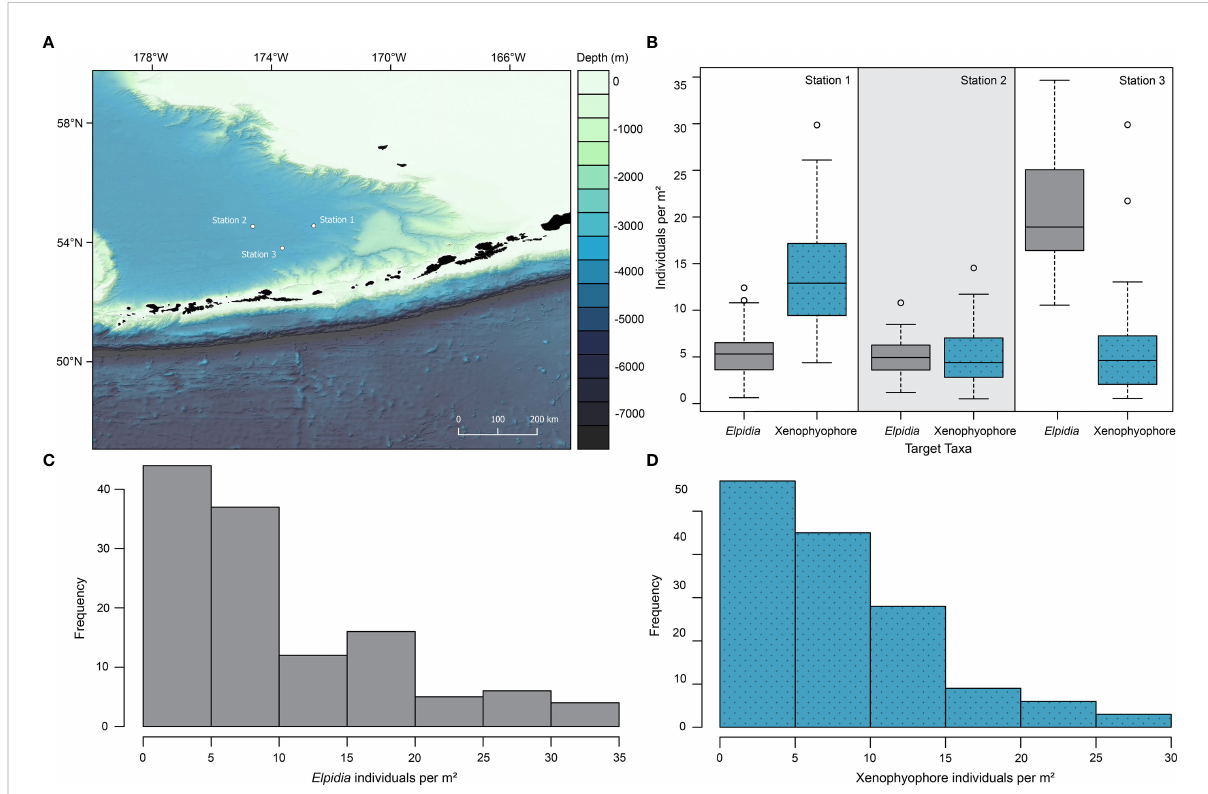
FIGURE 2 (A) Map of the study area in the Aleutian Basin, Bering Sea, surrounded by the Alaska mainland to the east, Aleutian Islands to the south, and Bower ’ s Ridge to the southwest. Regional bathymetry data from the General Bathymetric Chart of the Ocean (GEBCO) Project was used to generate this map (GEBCO Compilation Group, 2022). (B) Boxplot of comparative densities of Elpidia minutissima holothurians and xenophyophores in the Bering Sea, showing median and inner quartile measurements at each of the three stations. (C) Histogram of frequency distribution of Elpidia density in the Bering Sea (pooled data from the three stations). (D) Histogram of frequency distribution of xenophyophore density in the Bering Sea (pooled data from the three